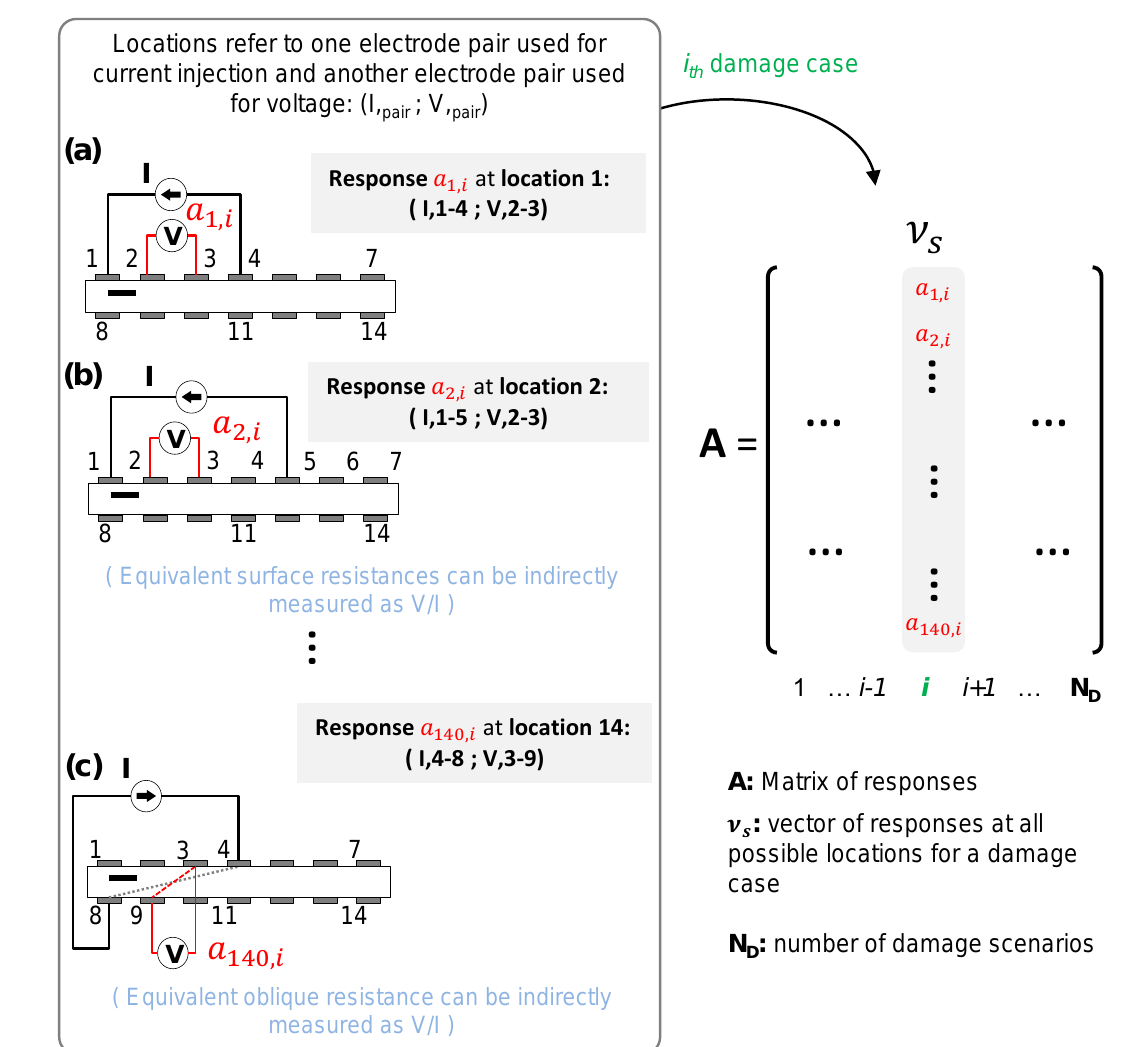
Figure 3. Scheme used for damage identification using four-probe schemes and two-sided electrodes. The matrix of observations A is obtained from the responses in order to apply effective independence. Responses are grouped by damage scenario in column vectors ( ν s ) in matrix A : ( a ) starting on the top surface with schemes for surface resistance; ( b ) following with an increase of electrode distance between electric current electrodes and ( c ) finishing with schemes used for oblique